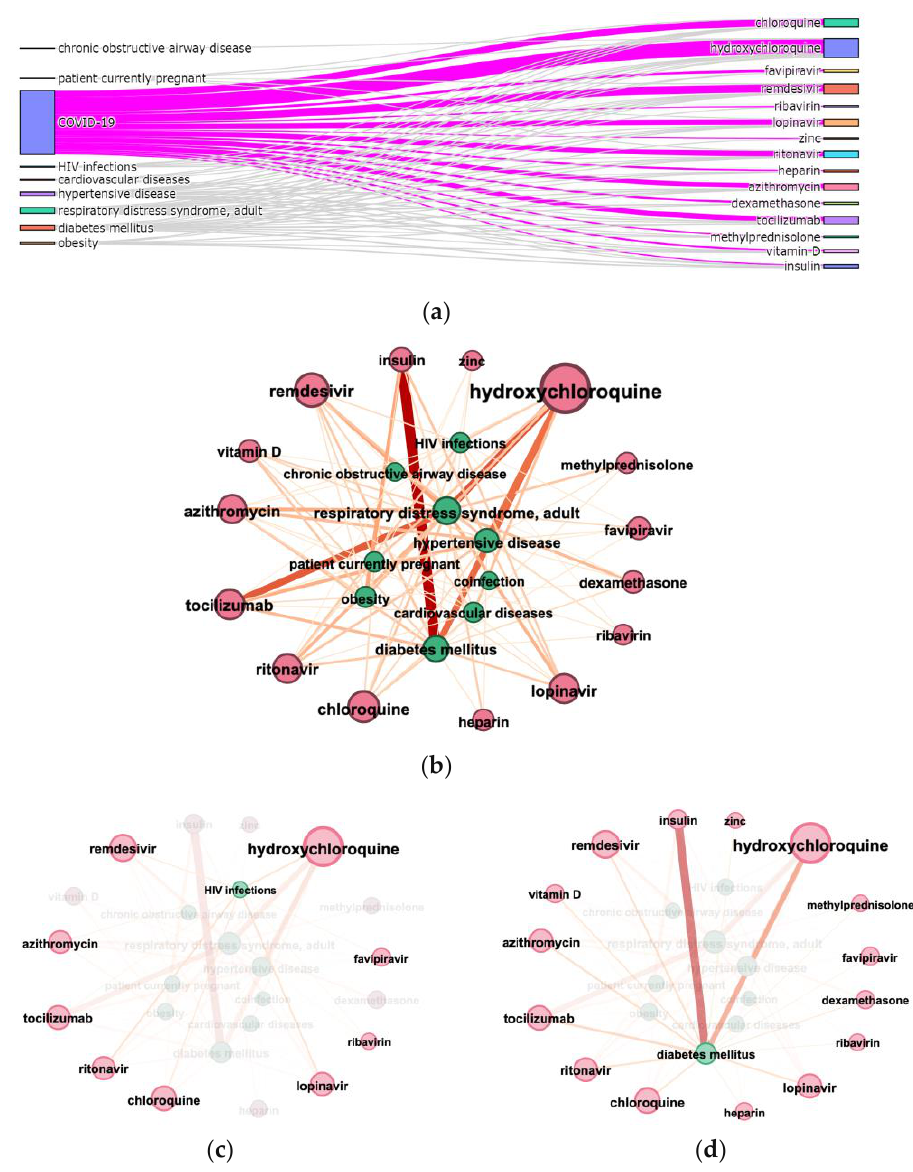
Figure 7. The connection between diagnoses and medicines in COVID-19 articles from 1 January 2019 to 1 February 2020 ( a ) Sankey diagram: diagnoses and medicines, the diagnoses list includes COVID-19; ( b ) connection graph: diagnoses and medicines, the diagnoses list excludes COVID-19; ( c ) connection graph: HIV infections (UMLS ID C0019693) and medicines; ( d ) connection graph: diabetes mellitus (UMLS ID C0011849) and medicines.